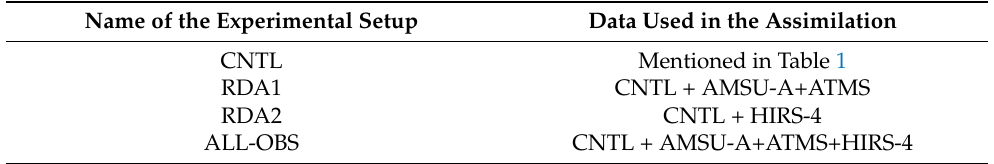
Table 2. Design of the experimental